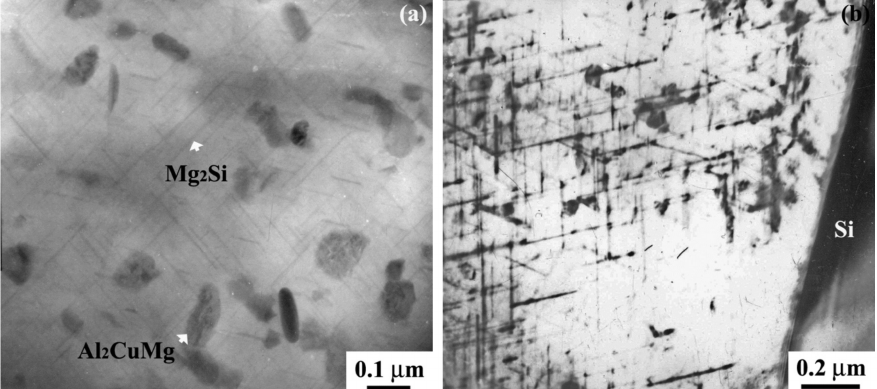
Figure 6. TEM images of Al-11.5Si-1.0Mg-0.5Cu-0.5Ni alloy after aging for 6 h: ( a ) A bright field image; and ( b ) Precipitates near Si